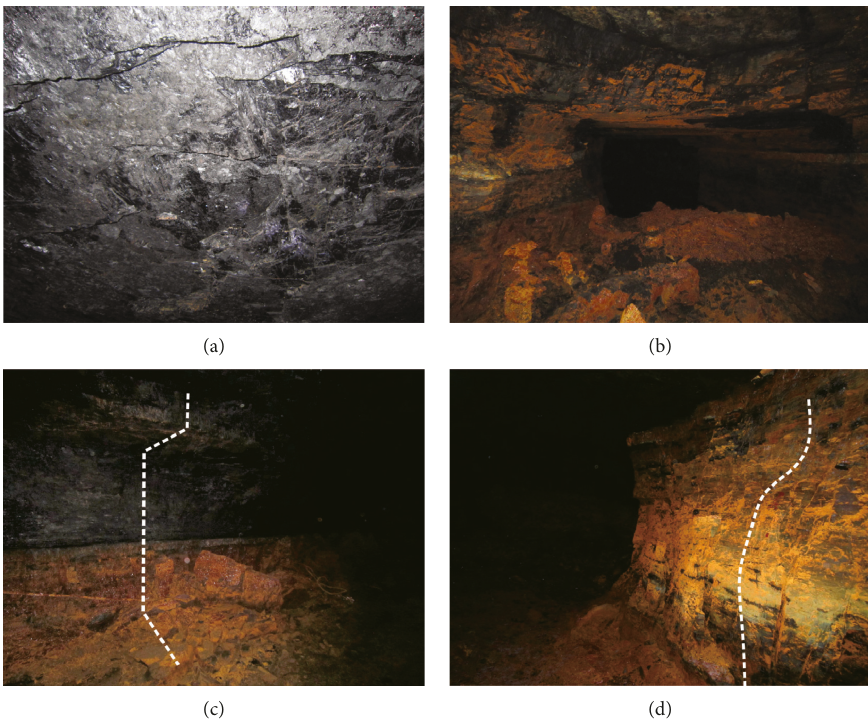
Figure 2: Site photos showing the failure condition of the roof and coal pillars in the #4 seam. (a) Cracks in exposed roof of the #4 seam. (b) Roof caving in one laneway of the #4 seam. (c) Lateral spalling of a coal pillar. (d) Splitting failure of the coal pillar.